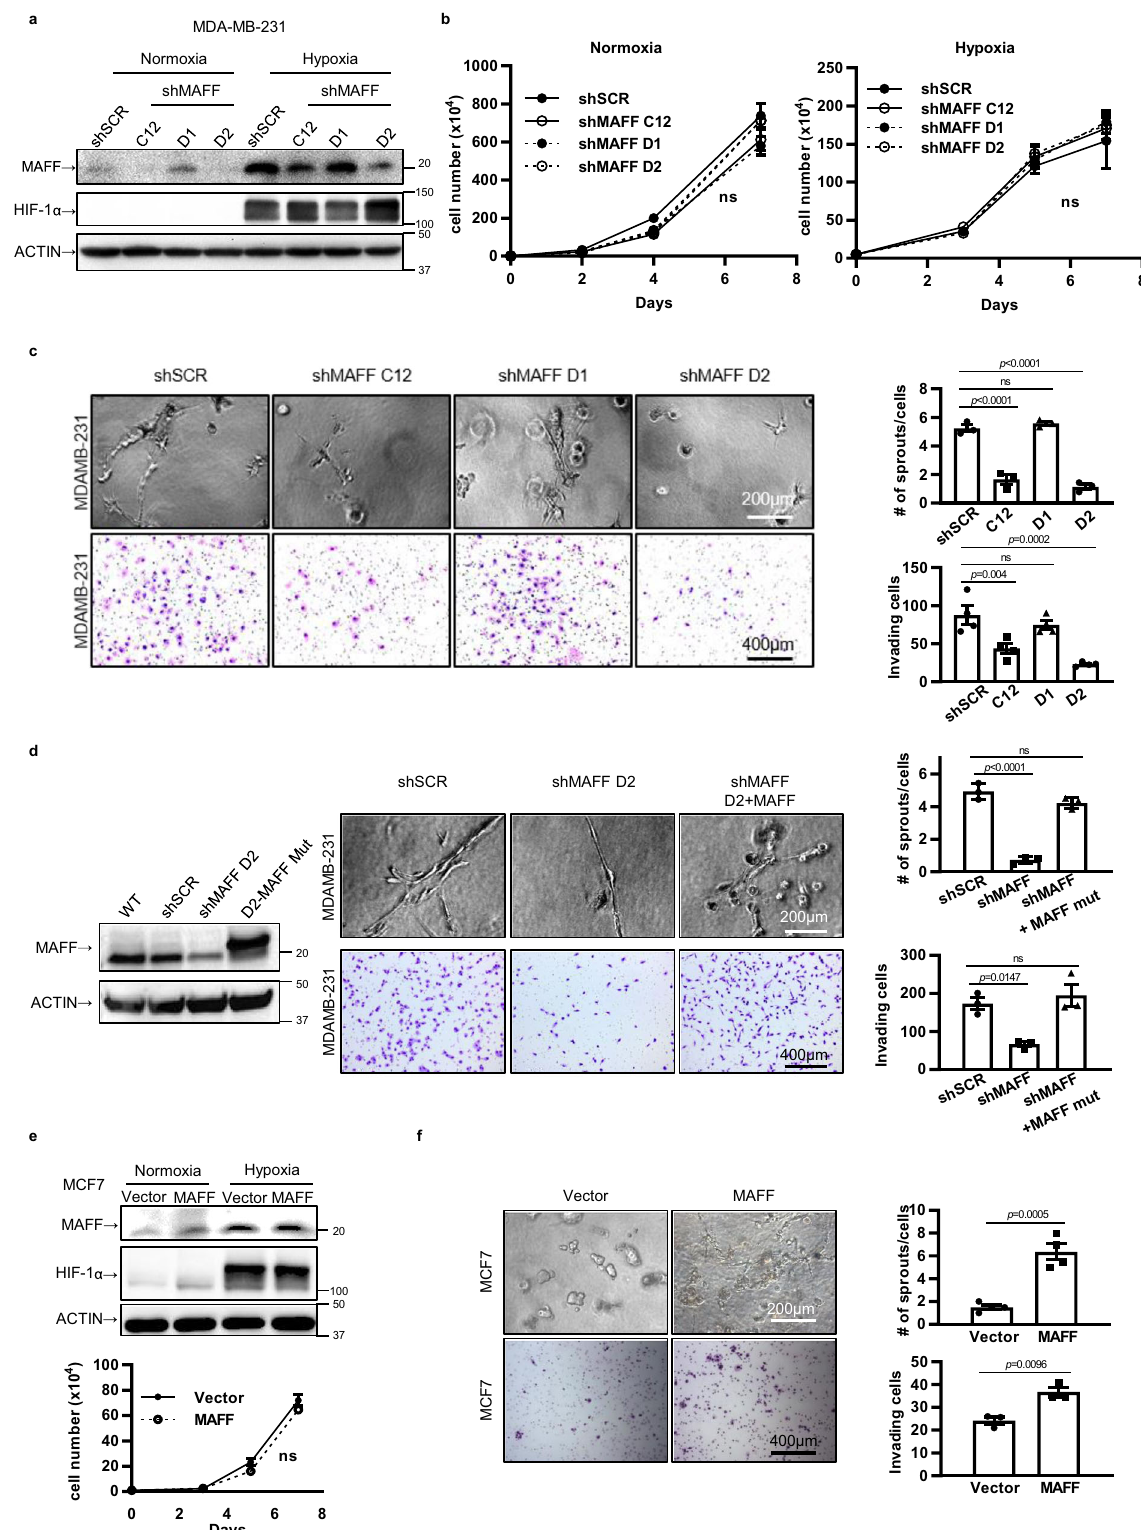
changed in the absence of MAFF expression (Fig. 5c). These biological functions of proteins encoded by genes identi fi ed from observations suggest MAFF-mediated gene activation and RNA-sequencing under normoxia or hypoxia or both conditions, repression while supporting our fi ndings on the role of MAFF in we performed DAVID analysis to determine KEGG pathways and tumor cell invasion and metastasis. GSEA data additionally Gene Ontology (GO) terms 20 and found that genes involved in showed that metastasis and migration-related genes were altered pathways of “ Blood vessel development ” , “ TGF β signaling ” , and “ Regulation of cell adhesion/morphogenesis ” were signi fi cantly by MAFF (Fig. 5d). NATURE COMMUNICATIONS| (2021) 12:4308